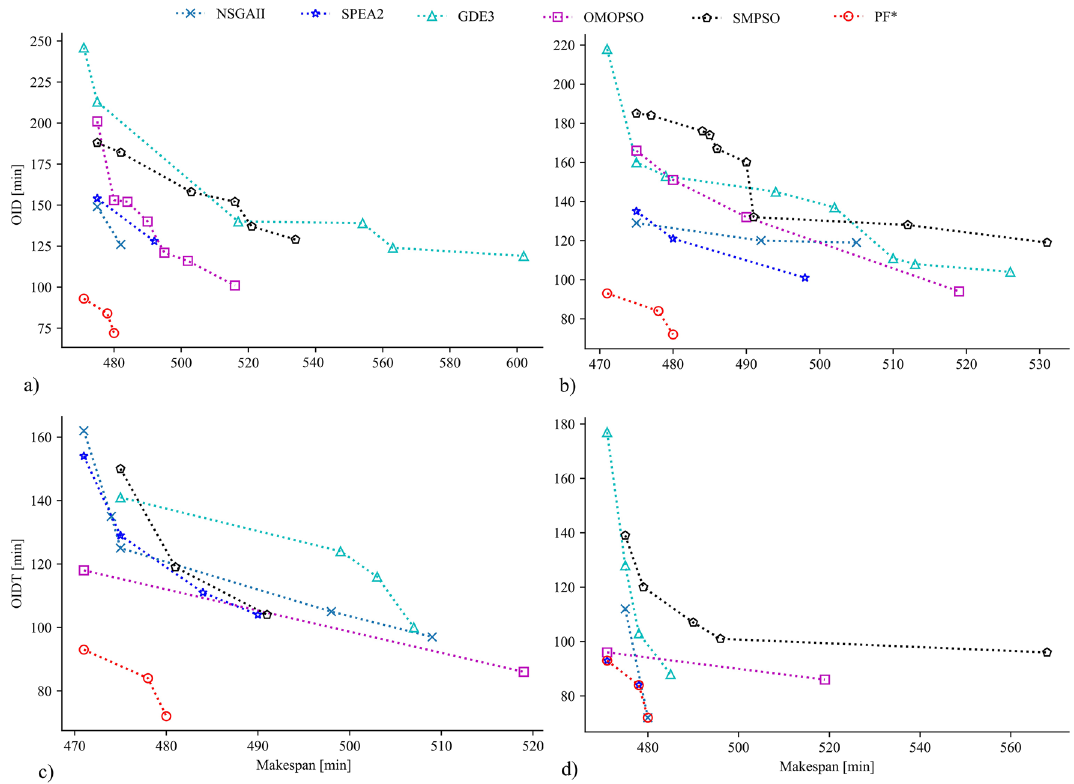
Figure 9. Candidate Pareto front (PF) for BK15 from optimization algorithms with—( a ) 50 iterations, ( b ) 100 iterations, ( c ) 200 iterations and ( d ) 300 iterations.